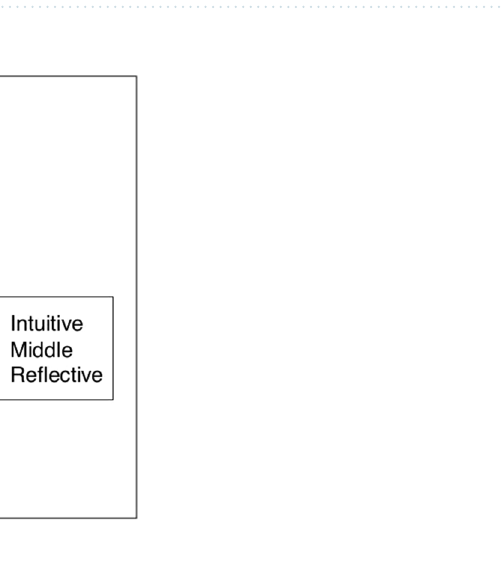
Figure 3. Calculated Coefficients of Model 4 (Table